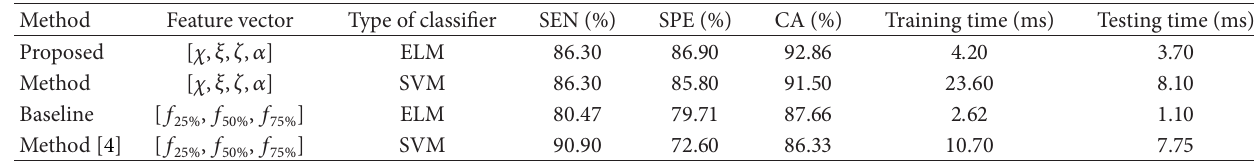
Table 2: Comparison of performances between the proposed and baseline methods